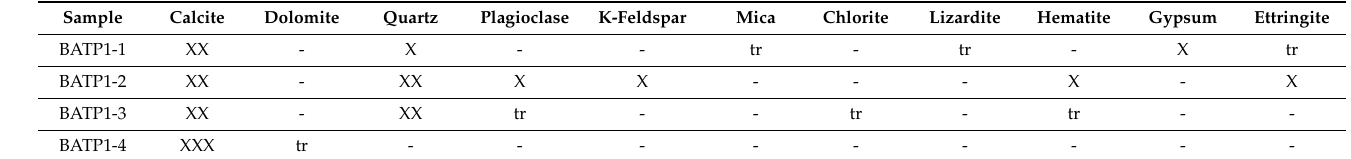
Table 2. Composition of the different portions of the core obtained by XRD analyses.